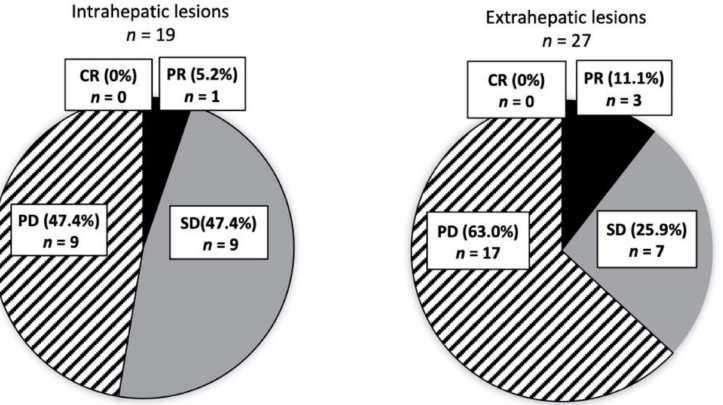
Figure 5. Response to TKI. The efficacies of TKI for intrahepatic ( n = 19) and extrahepatic lesions ( n = 27) were separately evaluated. Numbers of each extrahepatic lesion are as follows; PR, LN (lymph node) 2, Other 1; SD, Bone 3, Lung 2, LN 1, Other 1; PD, Bone 2, Lung 8, LN 3, Other